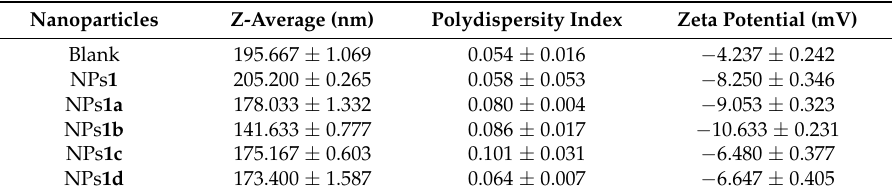
Table 4. Z-Average (nm), polydispersity index and zeta potential (mV) of developed NPs. All data were obtained from three replicates and values are expressed as the mean ± SD.